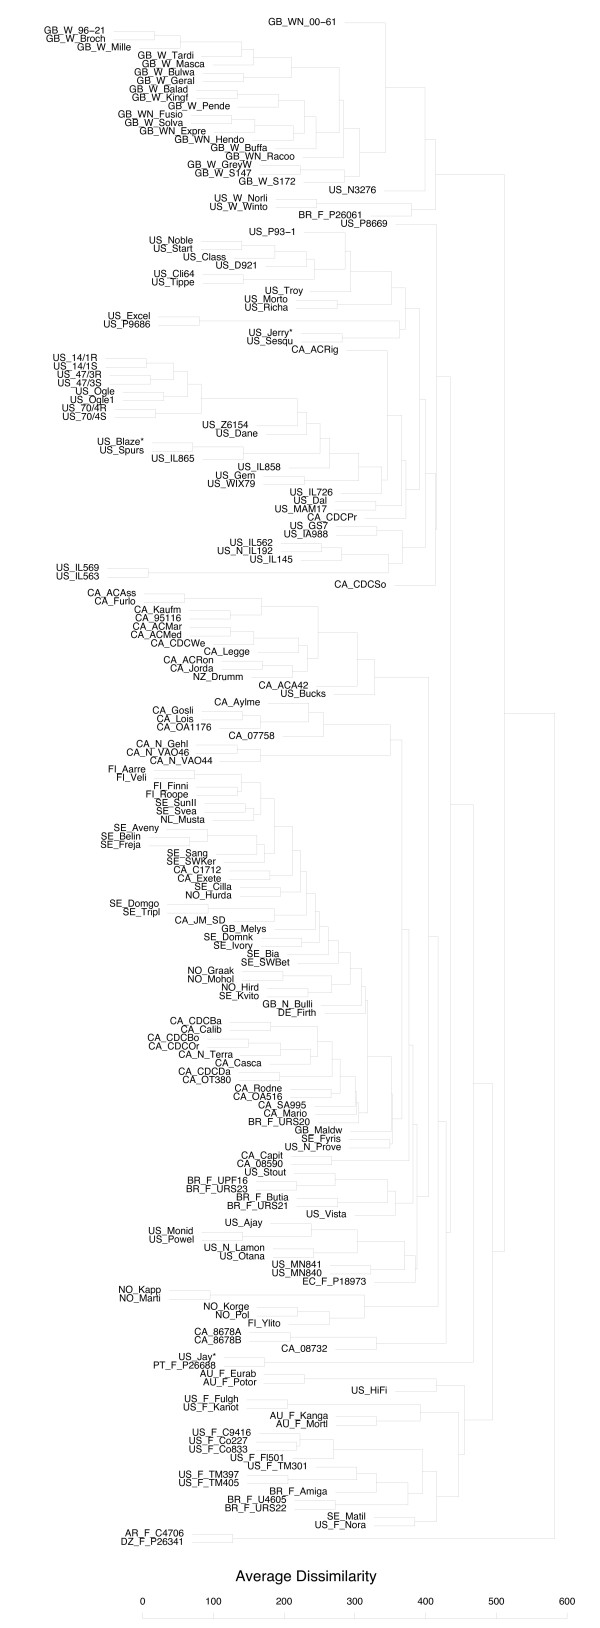
Cluster analysis of varieties. Agglomerative clustering using the un-weighted pair group method with averages (UPGMA) for 134 oat varieties using 1295 non-redundant DArT marker loci. Oat varieties are identified by truncated entry names, which are preceded by two-letter codes indicating country of origin, and by additional codes if they are winter-types (W), fall-sown but winter grown (F), or naked (N). See Additional file 1 for full entry names and country of origin codes. Clustering was implemented using the Agglomerative Nesting (AGNES) function in the R statistical environment [52]. The distance metric used was the Manhattan distance, which represents (in this case) the number of loci (out of 1295, adjusted for missing scores) for which two lines differed in their marker score. A high-resolution version of this figure is presented in Additional file 10.